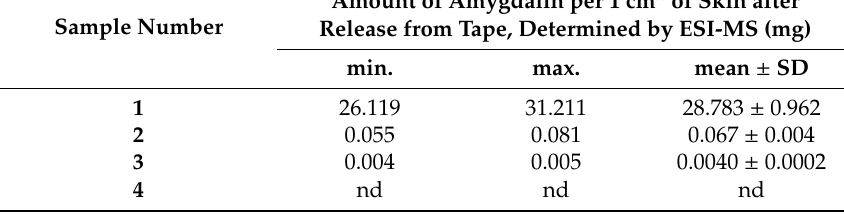
Table 8. Analysis of amygdalin skin